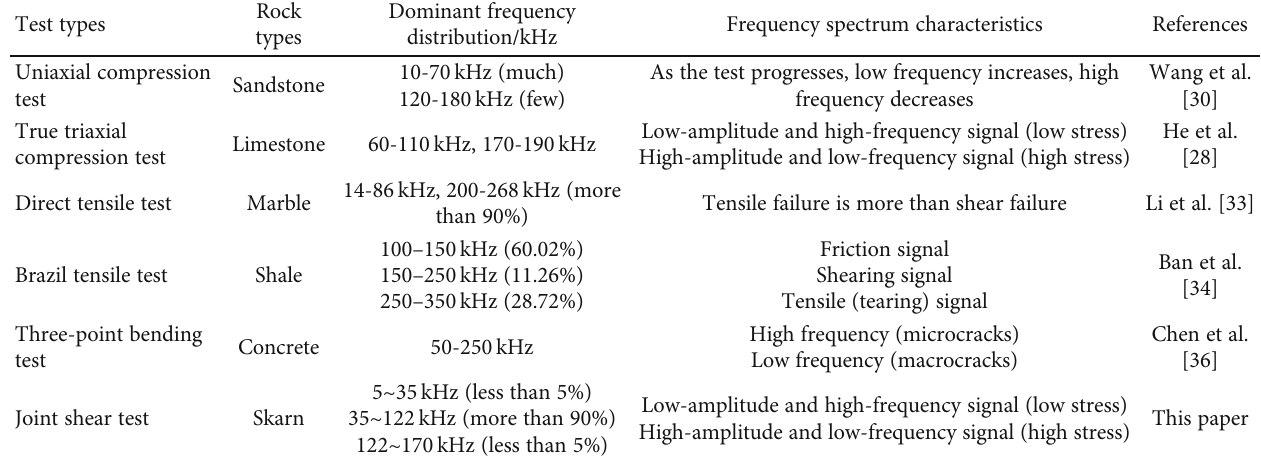
Table 5: Acoustic emission spectrum characteristics in di ff erent failure forms of